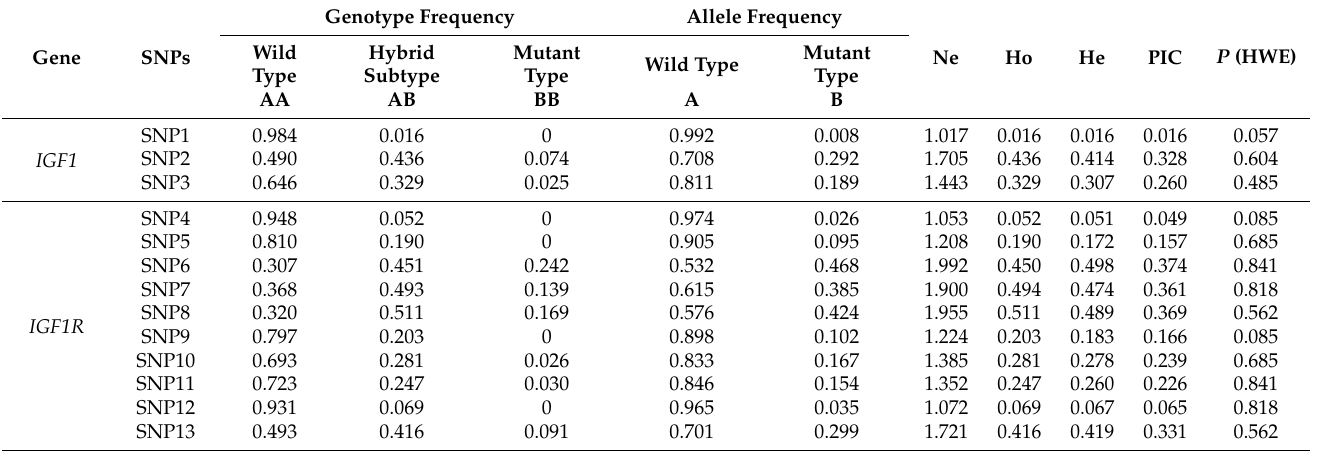
Table 2. Genetic diversity of the SNP loci within IGF1 and IGF1R genes in Hulun Buir sheep population.